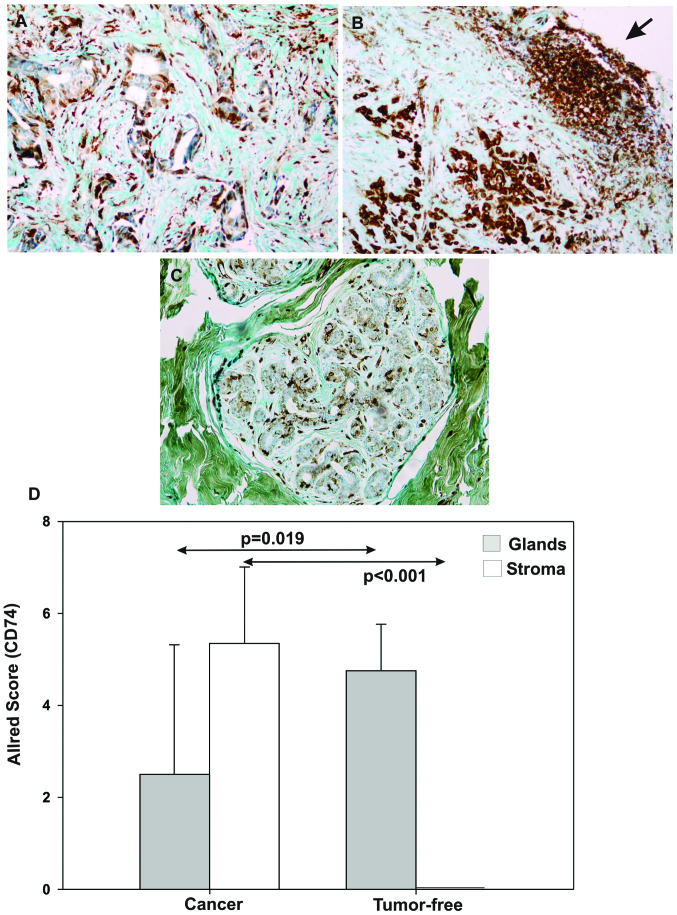
Immunohistochemical detection of CD74 in non-cancerous breast (C) and breast cancer tissue sections (A) with peritumoral lymphocytes (arrow, B). Semi-quantitative analysis (Allred score) of CD74 expression in glandular (Mann-Whitney test, p=0.019) and stromal (Mann-Whitney test, p<0.001) compartments (D).